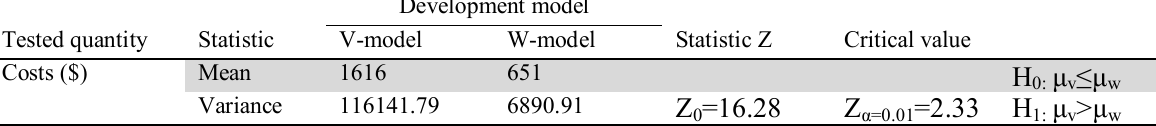
Results of design and construction costs of prototypes using V-model and